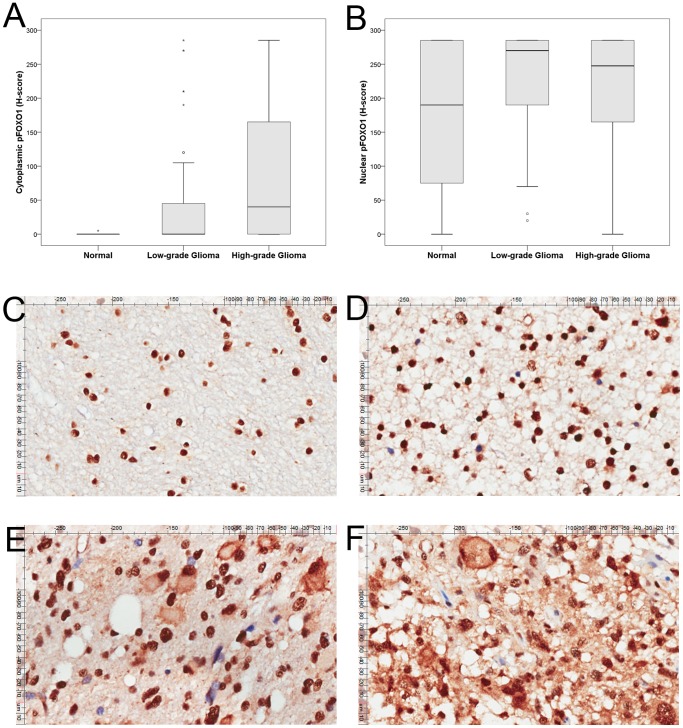
Tissue microarray analysis of pFOXO1 expression.(A, B) Cytoplasmic pFOXO1 expressions was higher in high-grade astrocytomas than low-grade and normal brain tissues. Nuclear pFOXO1 expression was comparable in three group. The horizontal line inside the box represents the median. The outliers are cases with the values between 1.5 and 3 box-lengths from the 75th percentile or 25th percentile. Representative images of pFOXO1 expression in normal brain tissue (C, ×200); grade II diffuse astrocytoma (D, ×200); grade III anaplastic astrocytoma (E, ×200) and grade IV glioblastoma (F, ×200).